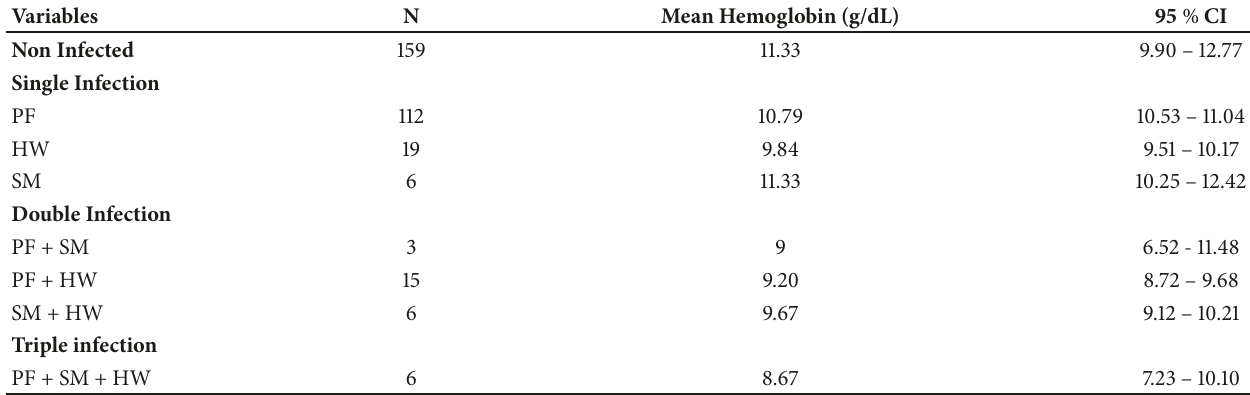
Table 5: The mean values of hemoglobin among noninfected and infected children in Northwest Ethiopia, 2016. Variables N Mean Hemoglobin (g/dL) Non